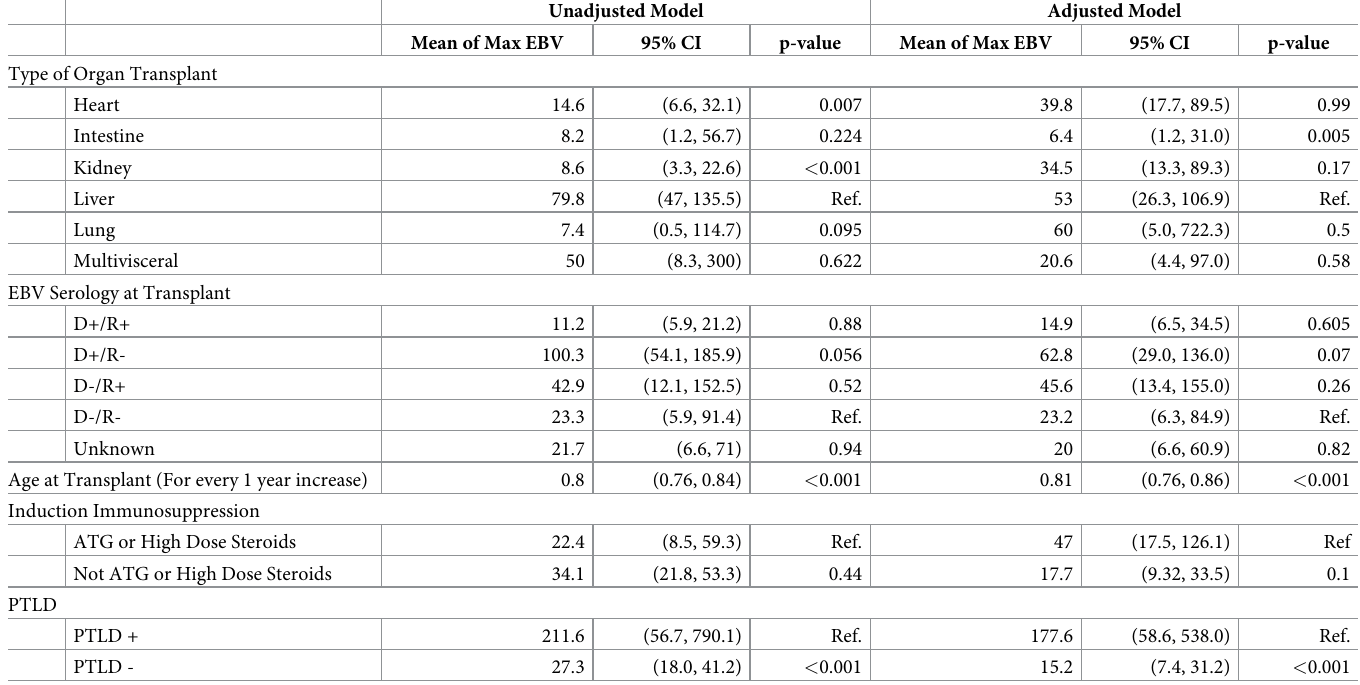
Table 5. The geometric mean maximum EBV value (Mean of Max EBV) in copies/uL is shown for each demographic group in an unadjusted model, and an adjusted